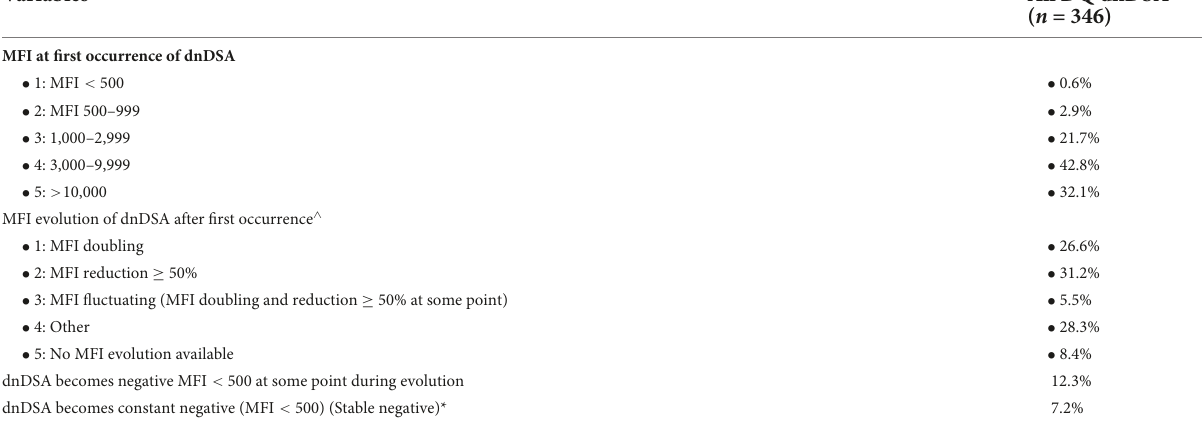
TABLE 5 MFI values at first occurrence and MFI evolution of DQ-dnDSA analyzed by Luminex R (cid:13) .